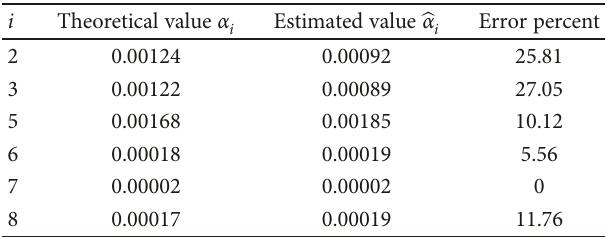
Table 2: Estimation of the parameters in (72), corresponding to the equalities in